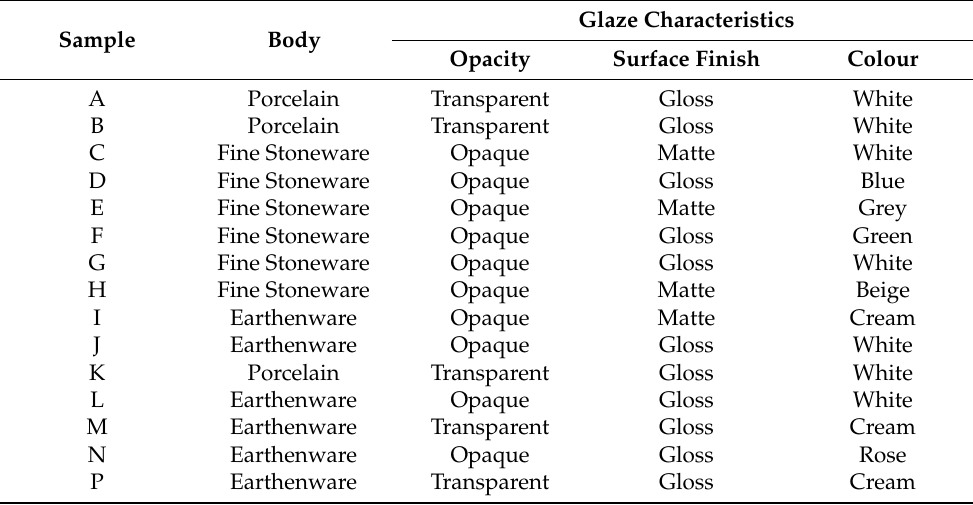
Table 4. List of tested tableware bodies and